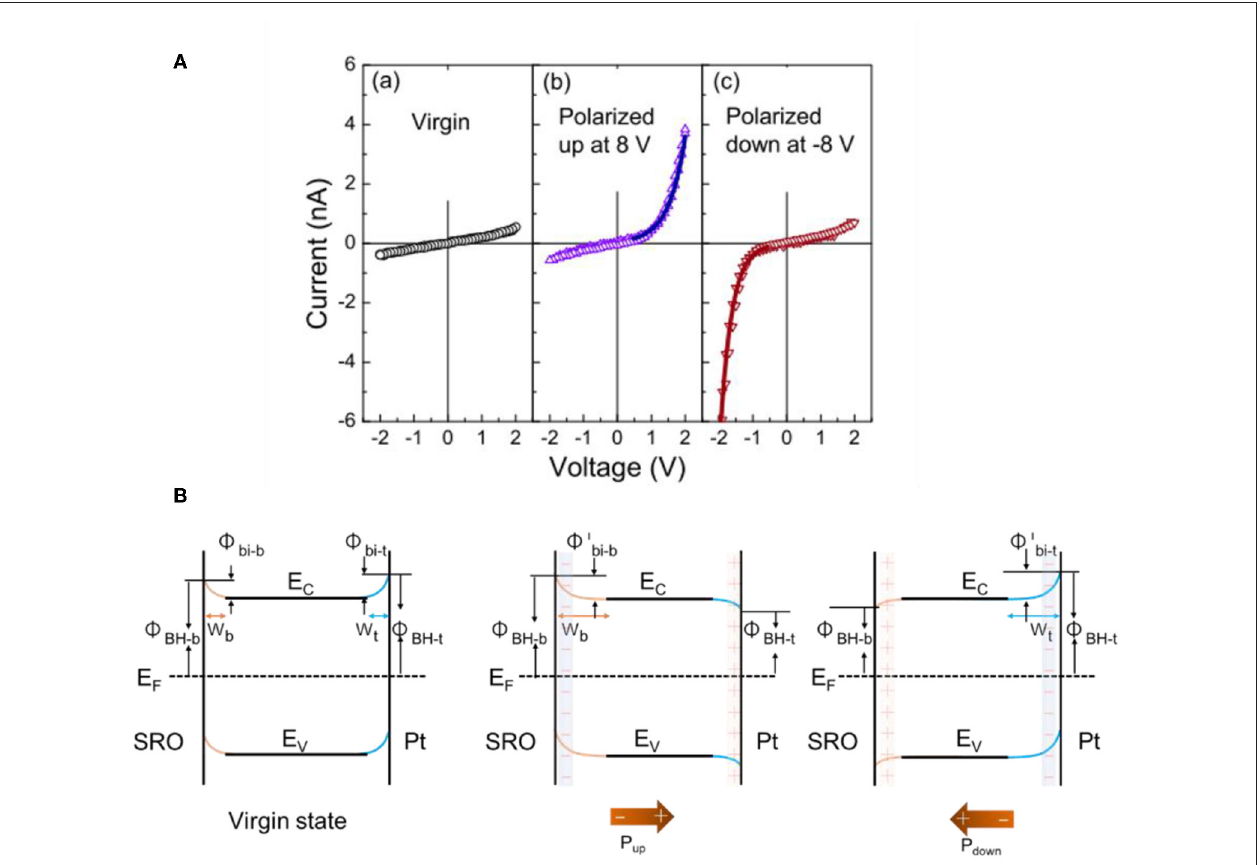
FIGURE 7 | Band-bending at SRO/BFO/Pt heterojunctions. (A) I–V characteristics at left: virgin state, middle: polarized up state, and right: polarized down state. (B) Proposed energy band diagrams at different ferroelectric polarization states. Left: virgin state. Middle: polarization up state. Right: polarization down state. Figures adapted from Wang et al. (2011). Copyright 2011 AIP